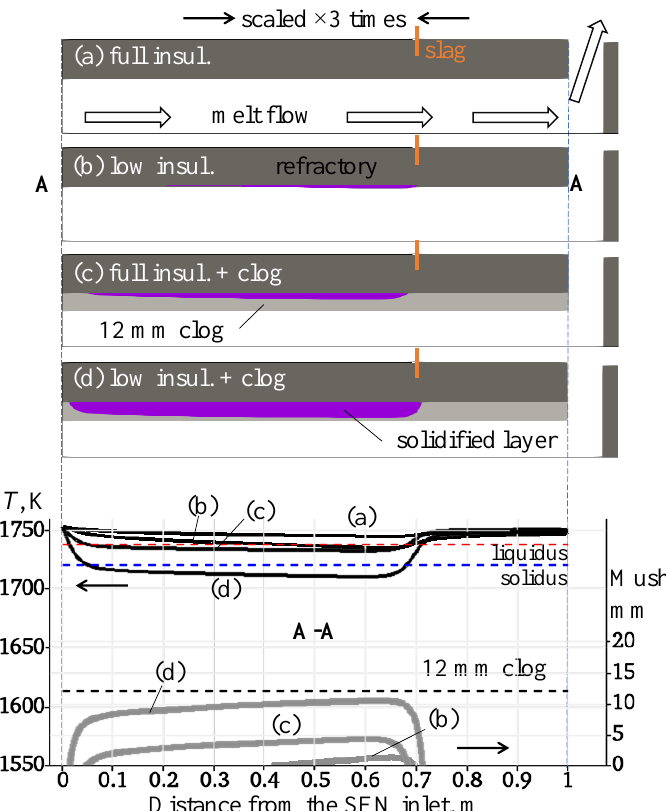
Figure 6. Solidified steel inside the SEN (top figures ( a )–( d )) and the temperature distribution/mush thickness along the SEN inner wall (line A-A): ( a ) insulation of the SEN with a fiber layer; ( b ) low insulation of the SEN; ( c ) full insulation of the SEN and formation of the 12 mm clog layer; ( d ) low insulation of the SEN and formation of the 12 mm clog layer.